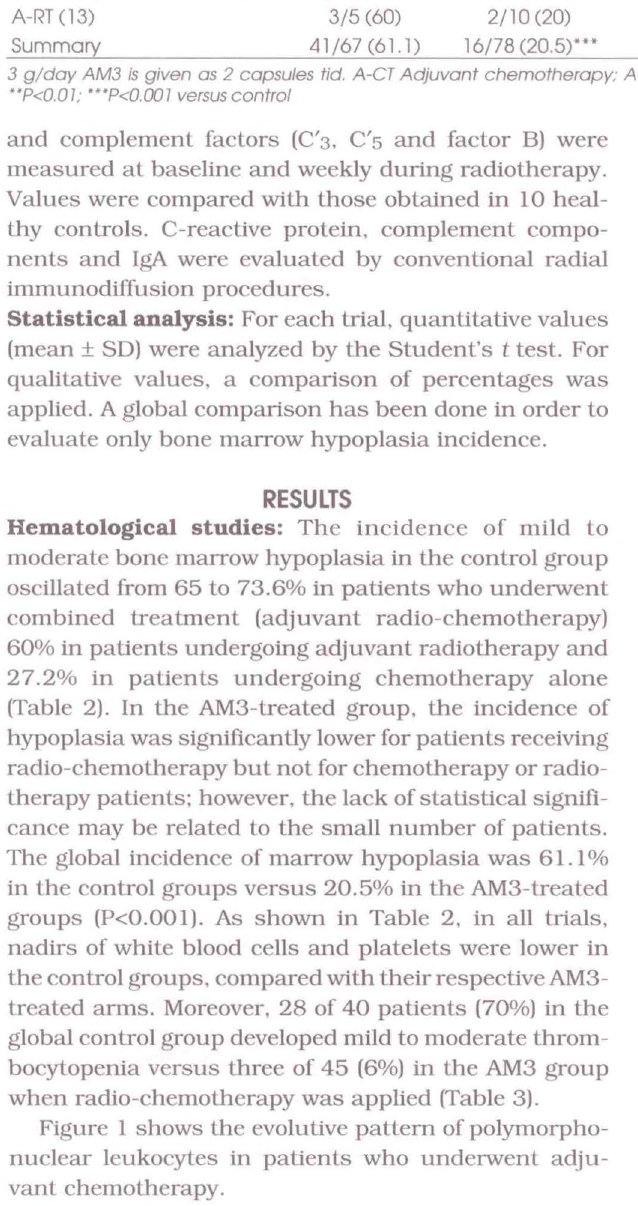
Incidence of bone marrow hypoplasia and leukocyte and platelet nadirs in breast cancer patients under adjuvant cytotoxic therapies - effects of treatment with AM3 Bone marrow hypoplasia